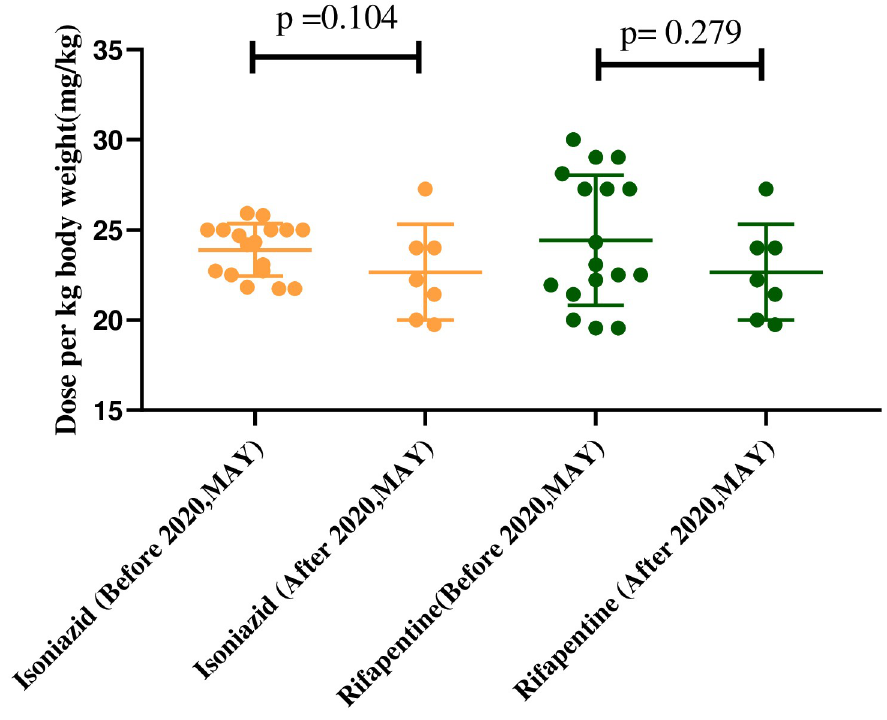
Fig 1. Dose of anti-tuberculosis per kilogram of body weight (24